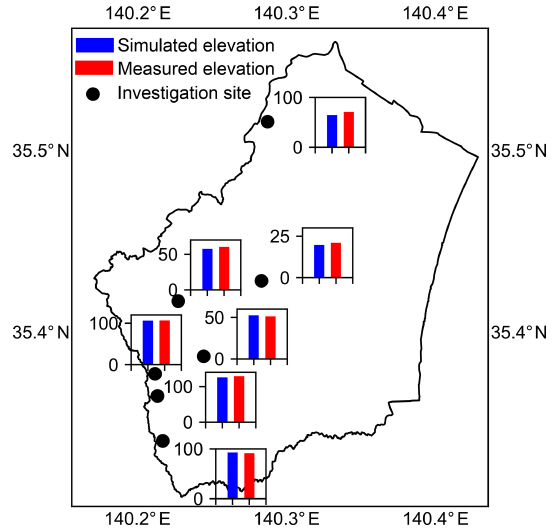
Figure 3. Comparison of simulated and measured spatial distribu- tion of groundwater